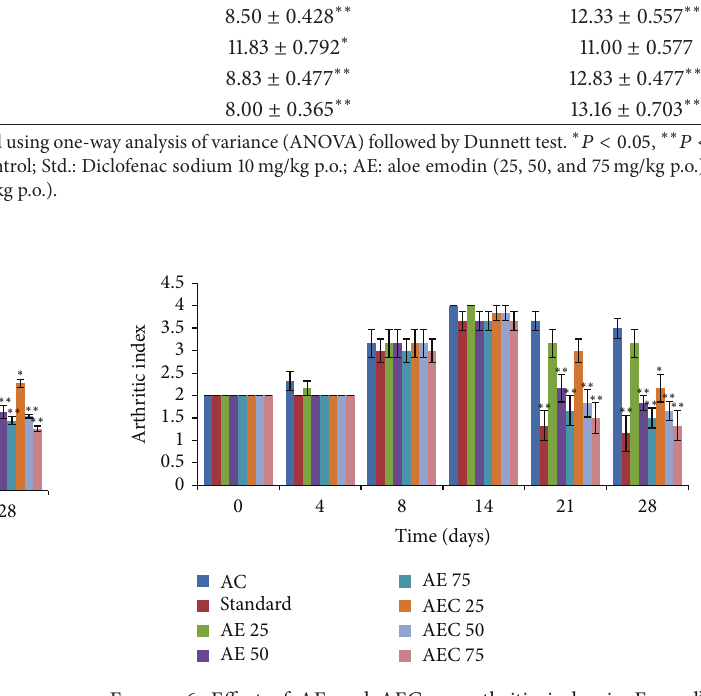
Figure 5: Effect of AE and AEC on noninjected paw volume in Freund’s complete adjuvant induced arthritic rats. Results were presented as mean ± SEM ( 𝑛 = 6 ). The data was analysed using one-way analysis of variance (ANOVA) followed by Dunnett test. ∗ 𝑃 < 0.05 , ∗∗ 𝑃 < 0.01 when compared with arthritic control group. AC:arthriticcontrol;Std.:Diclofenacsodium10 mg/kgp.o.;AE:aloe emodin (25, 50, and 75 mg/kg p.o.); AEC: carboxylic acid derivative of aloe emodin (25, 50, and 75 mg/kg p.o.).